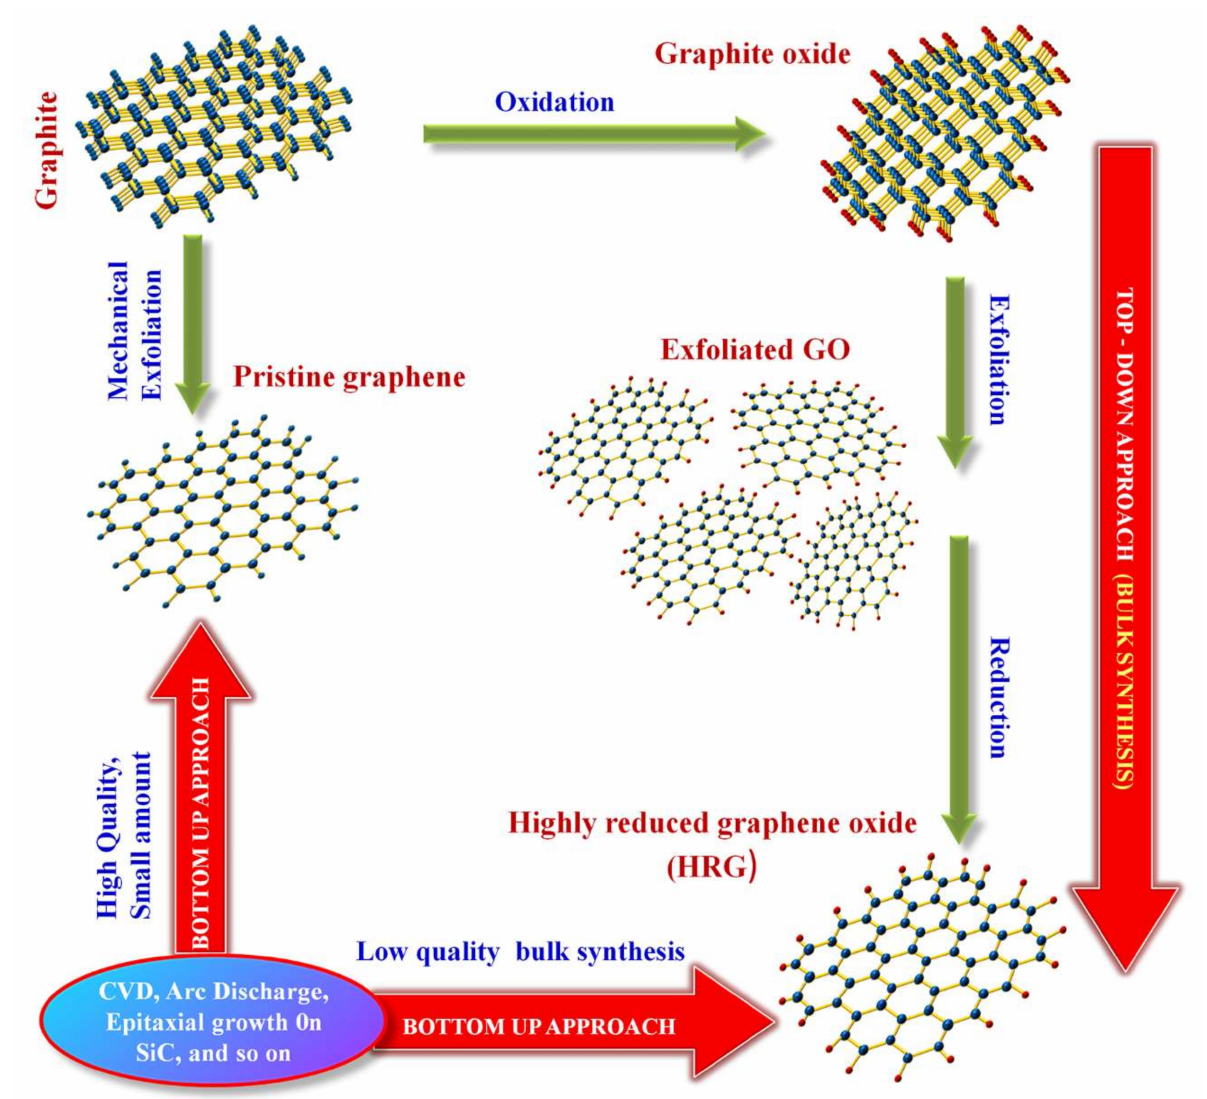
Figure 5. Pictorial representation of the synthesis method of graphene, categorized by the top-down along with bottom-up techniques. Adapted and reproduced from Ref. [23]. Copyright 2015 Royal Society of